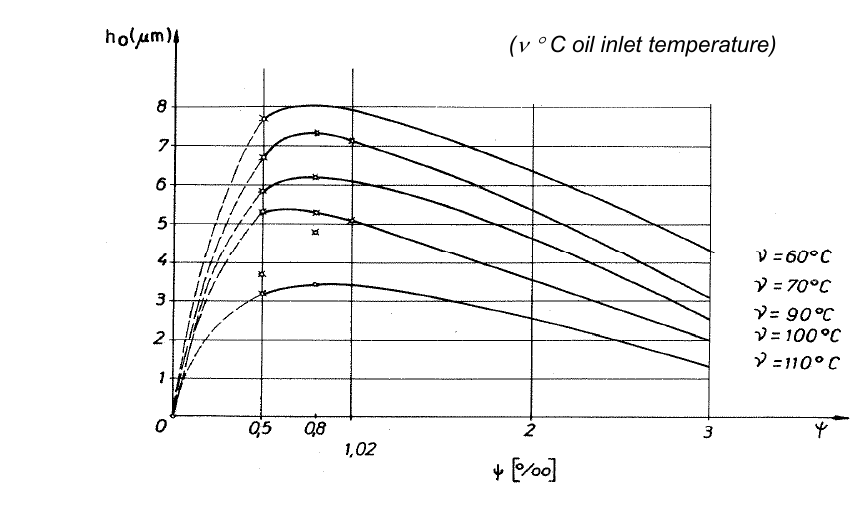
Figure 1 – Minimum thicknesses of the oil film depending on the relative clearance of the